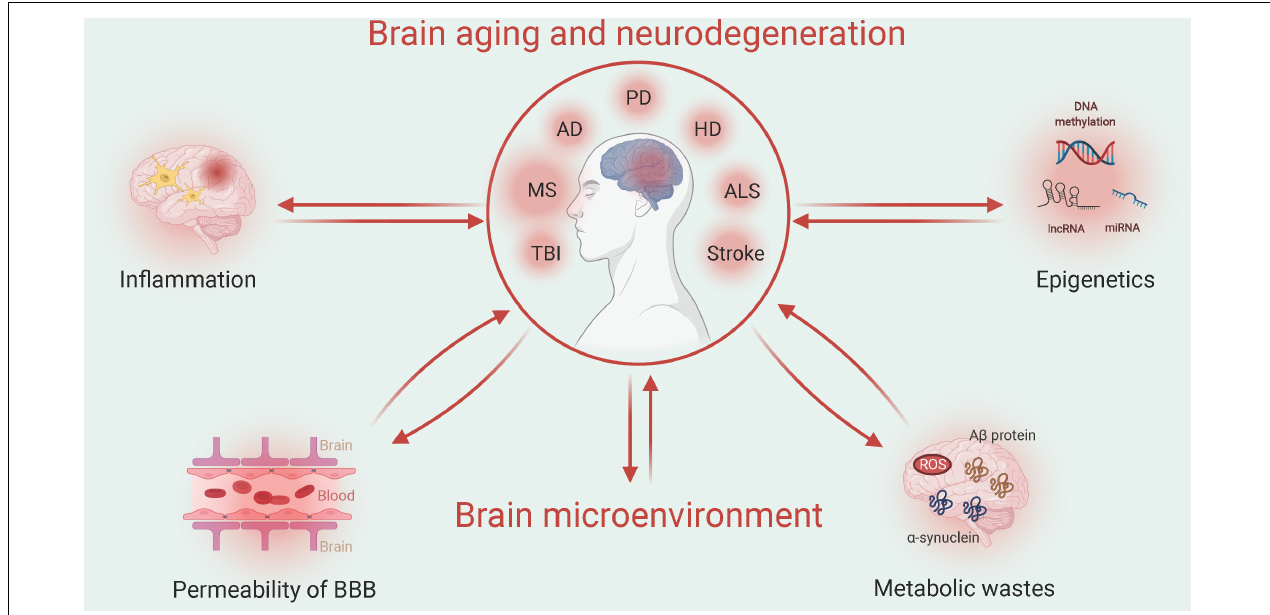
FIGURE 2 | Molecular pathways of CR on neuroprotection (Created with BioRender.com). As the energy sensor, AMPK-mTOR pathways respond to CR by reacting to the metabolic status of cells. As the intracellular pathway, nicotinamide adenine dinucleotide-mediated sirtuin affects gene expression to generate neurotrophic factors such as BDNF. Downstream of Sirtuin 1, PGC-1 α modulates mitochondrial biogenesis and function, which affects cellular metabolism.